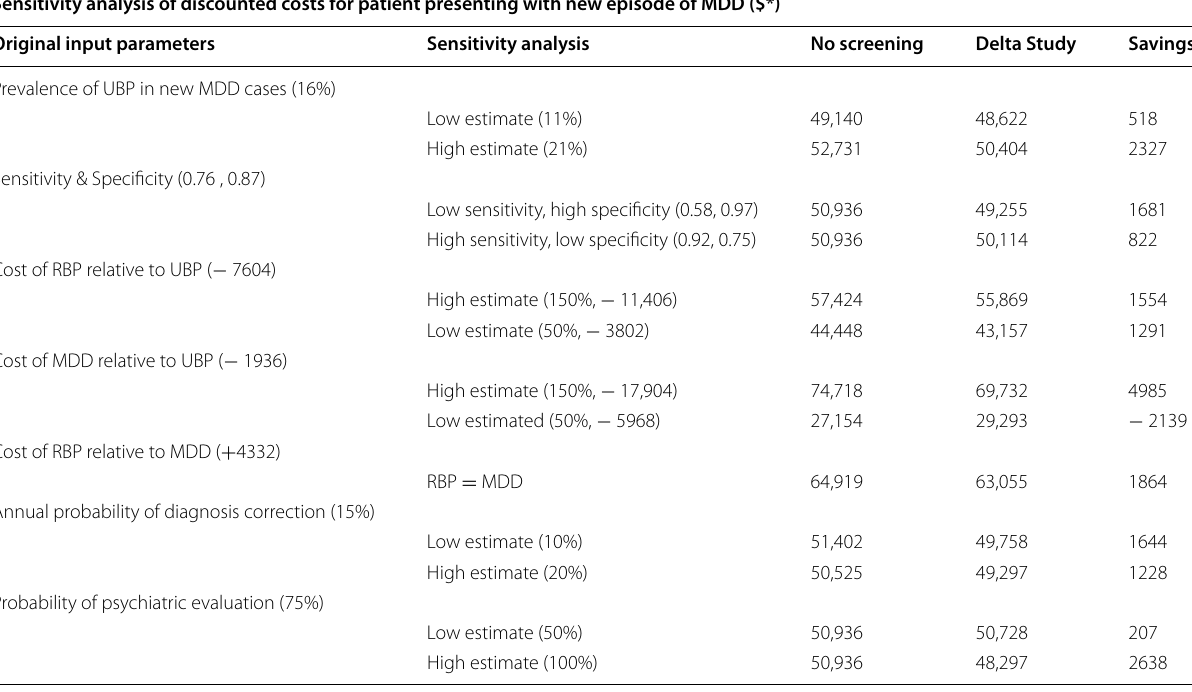
RBP: Recognised bipolar disorder patients; MDD: Major depressive disorder; UBP: Unrecognised bipolar disorder patients; CI: Confidence